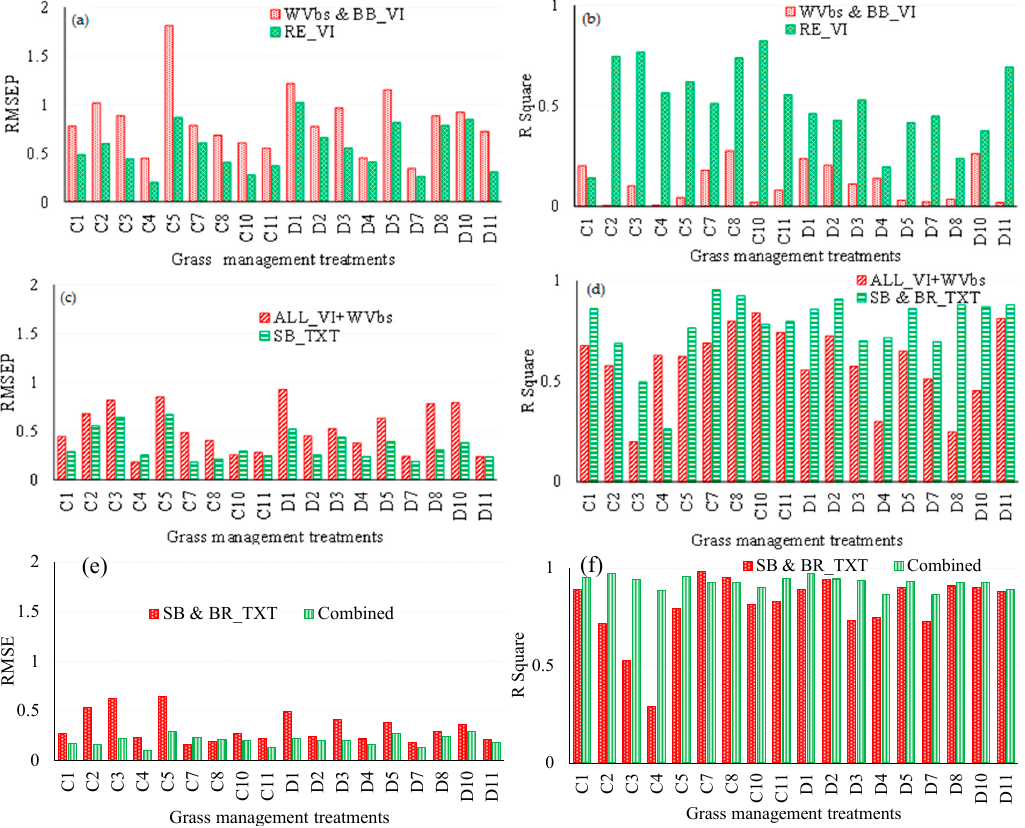
Figure 4. A comparison of estimation accuracies derived using different WV-3 satellite data and its derivatives. Root mean square error of prediction (RMSEP) and R squares obtained in comparing ( a , b ) WV-3 combined BB_VIs and red-edge vegetation (RE_VIs) ( c , d ), all VIs combined with WVbs and single-band texture models (SB_TXT) and ( e , f ) SB_TXT) and all data combined. C1–11 and D1–11 are illustrated in Table 1.